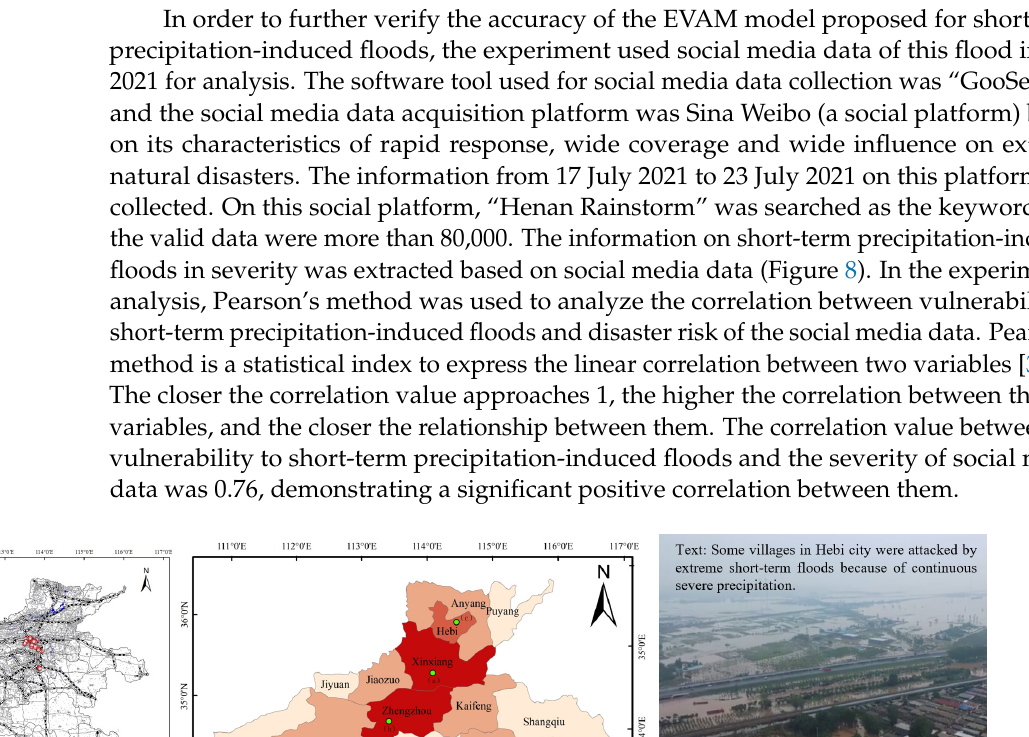
Figure 7. Results of vulnerability assessment in Henan Province.